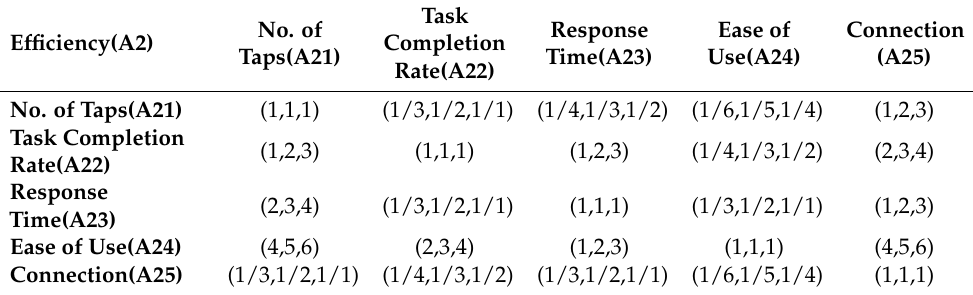
Table 6. Fuzzy-based comparison matrix associated with the sub-criteria in relation to the efficiency (A2) criteria.